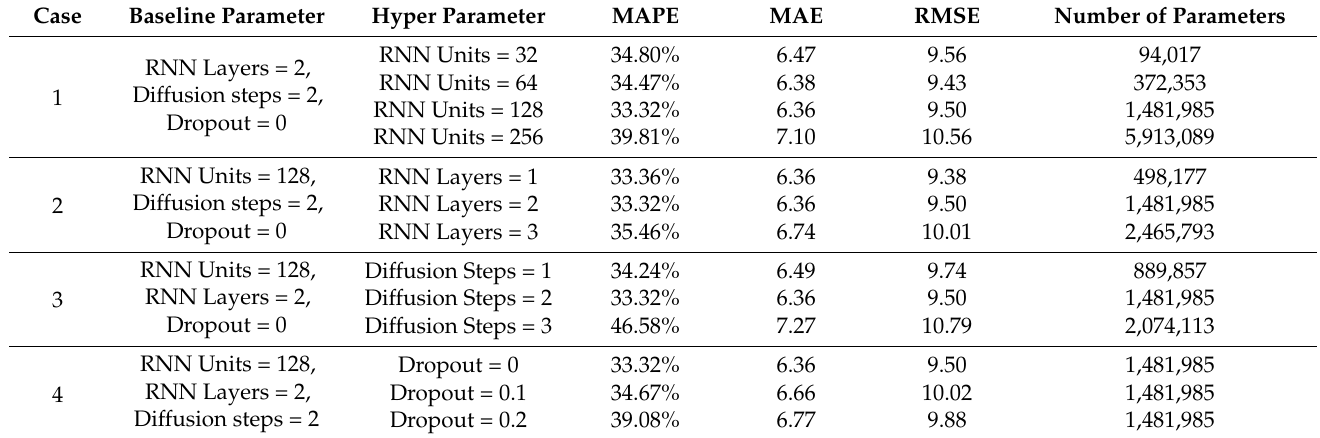
Table 1. Four sets of experiments on